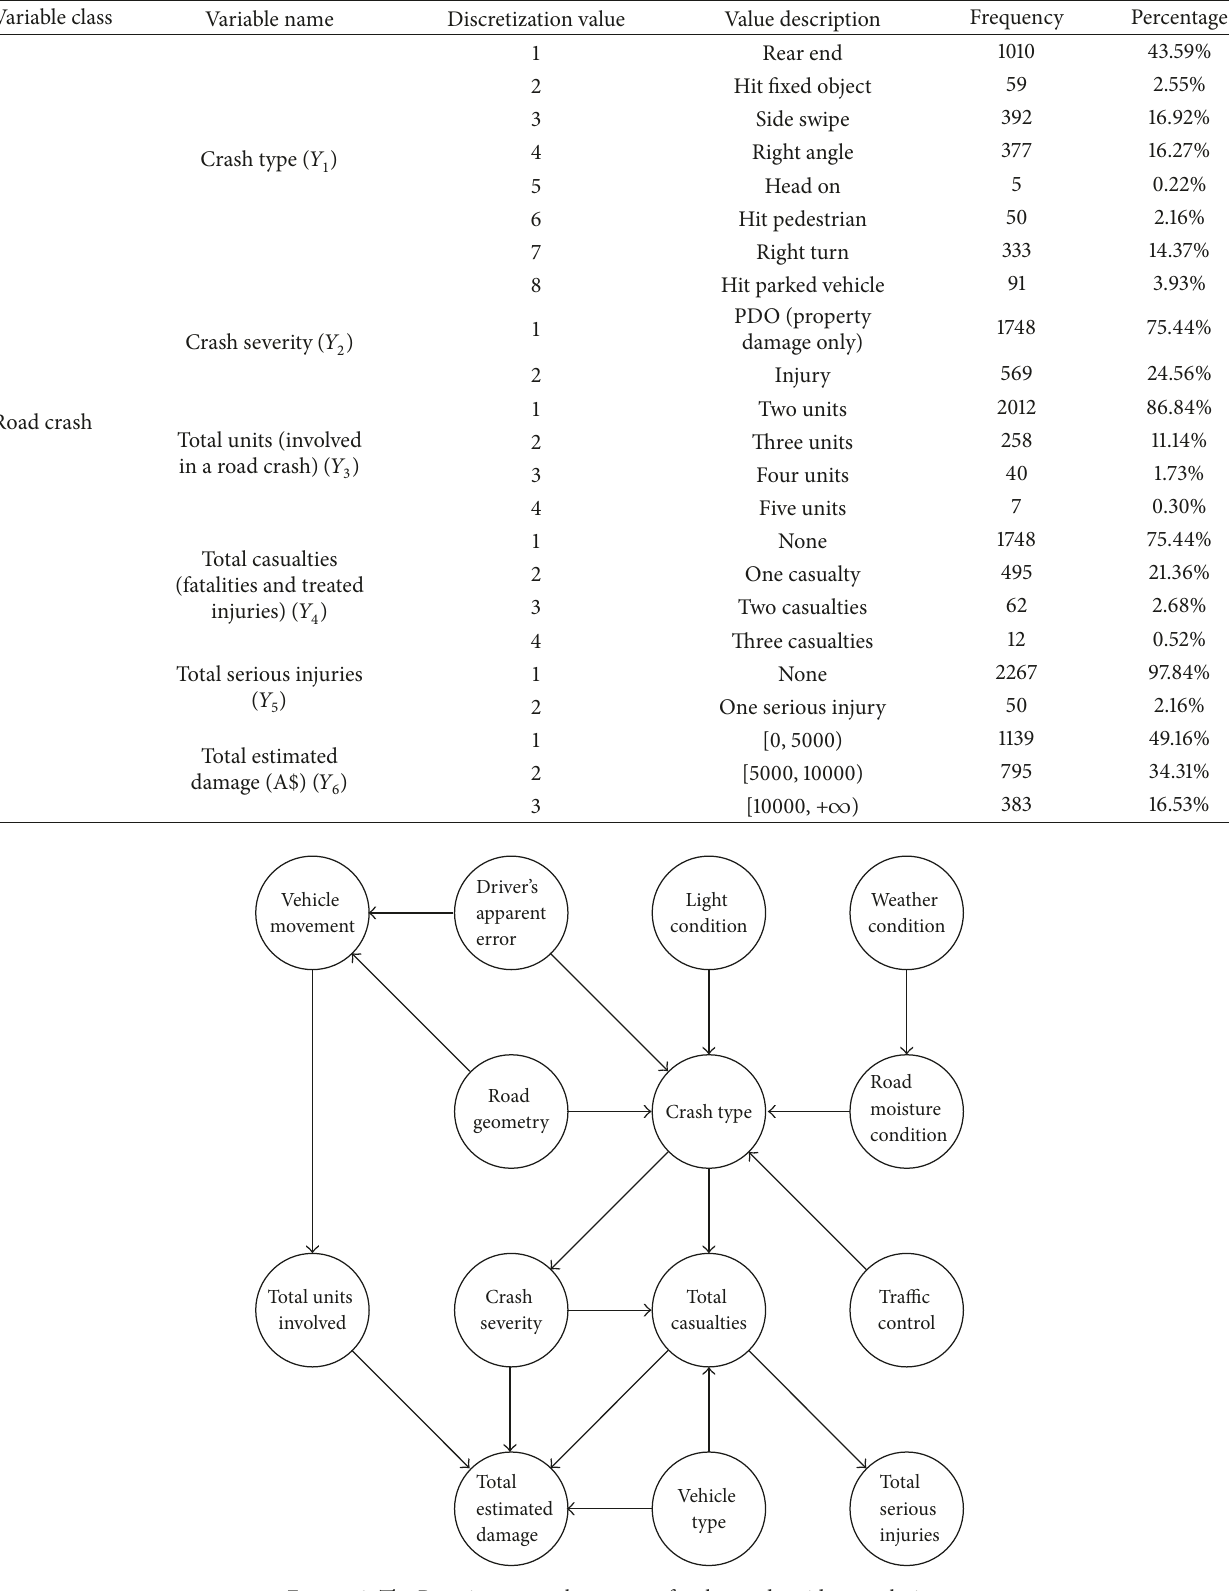
Figure 3: The Bayesian network structure for the road accident